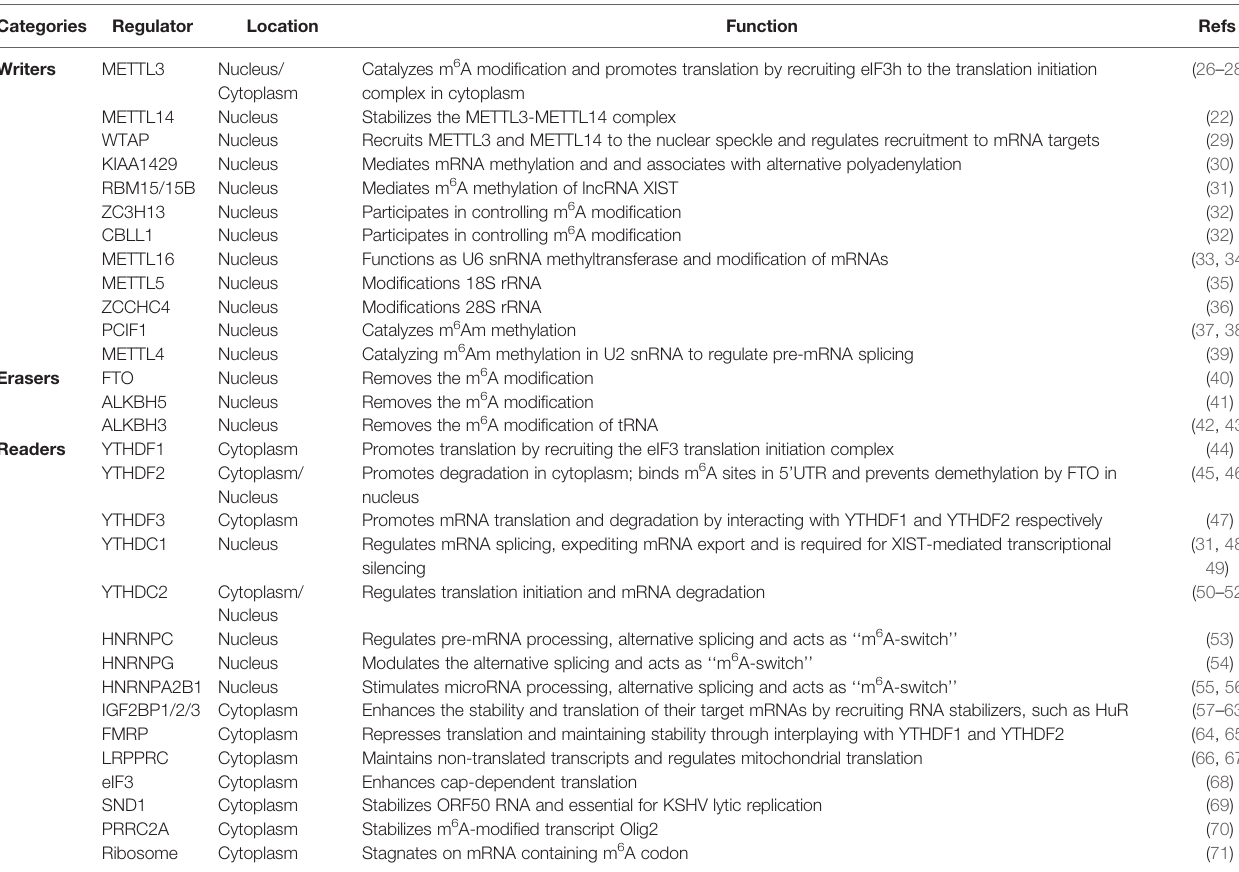
TABLE 1 | Functions of m 6 A related regulators in RNA